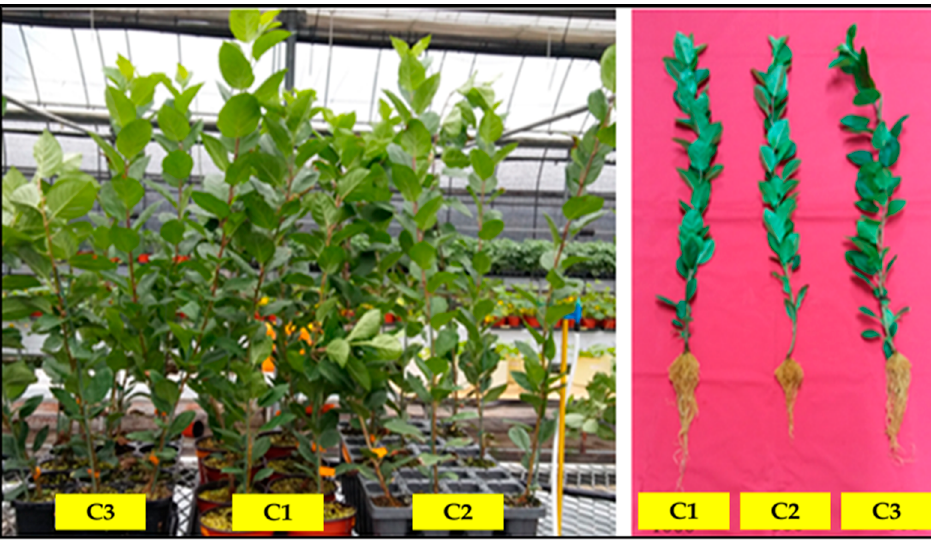
Figure 5. Effect of container size on the growth of M-9 apple rootstock plants at 11 weeks after treatment in a greenhouse. C1, C2 and C3 indicate container size 1000 mL, 500 mL and 300 mL, respectively.